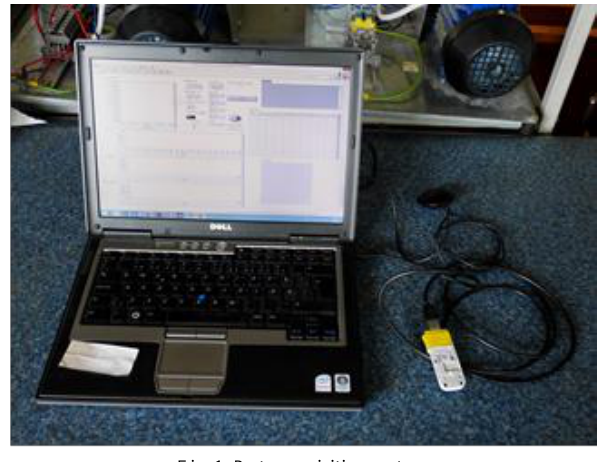
Fig. 1. Data acquisition system.